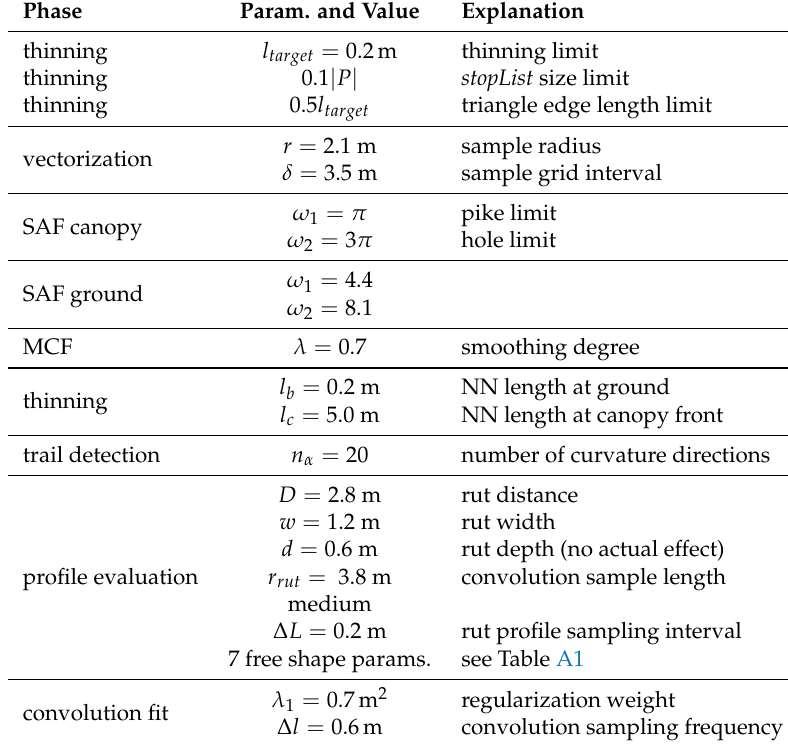
Table 2. The 25 parameters, their values and a short